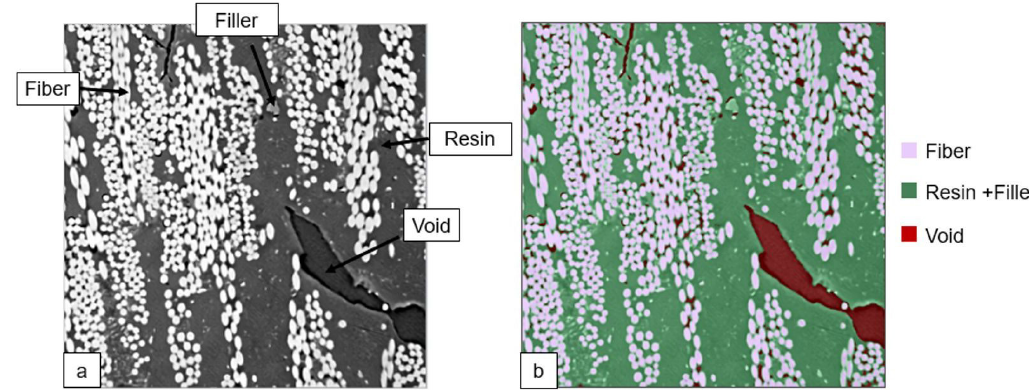
Figure 13. Result of segmentation of Tomo 3 using Trainable Weka Segmentation: (a) original image; (b) segmented image.